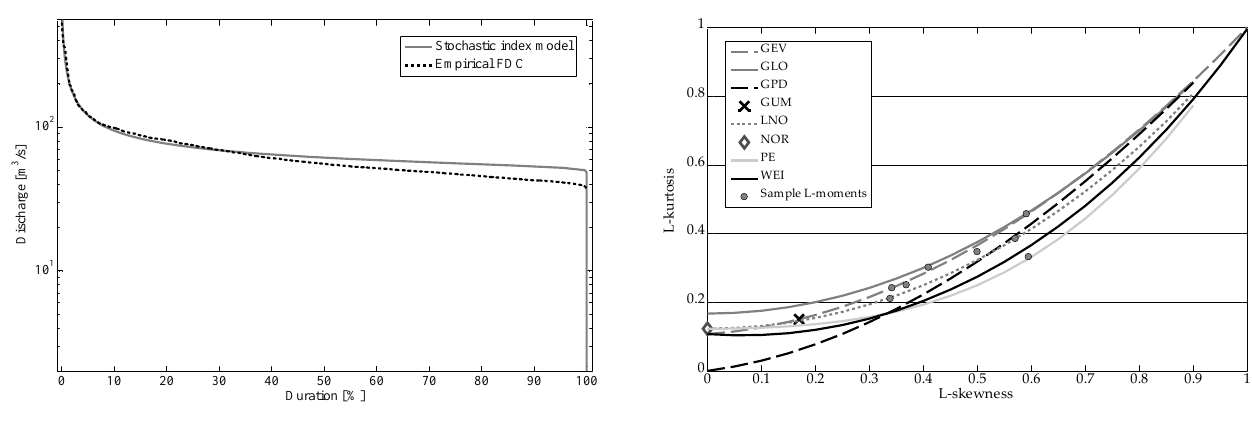
Fig. 10. L-moment ratio diagram of L-kurtosis vs. L-skewness, used to choose the parent distribution. Distributions in the diagram are: Normal (NOR), Gumbel (GUM), Generalized extreme values (GEV), Generalized logistic (GLO), Generalized Pareto (GPD), Generalized normal (LNO), Pearson type III (PE), Weibull (WEI). Table 8. Observed parameters for the stations of Region 4 (Apen- nine area) used for the regionalisation approach. µ and σ are the mean and standard deviation of the AF data; κ , λ and ξ are the shape parameter, scale parameter and location parameter of the GEV dis- tribution of the X 0 data; p nz is the percentage of time that the river is